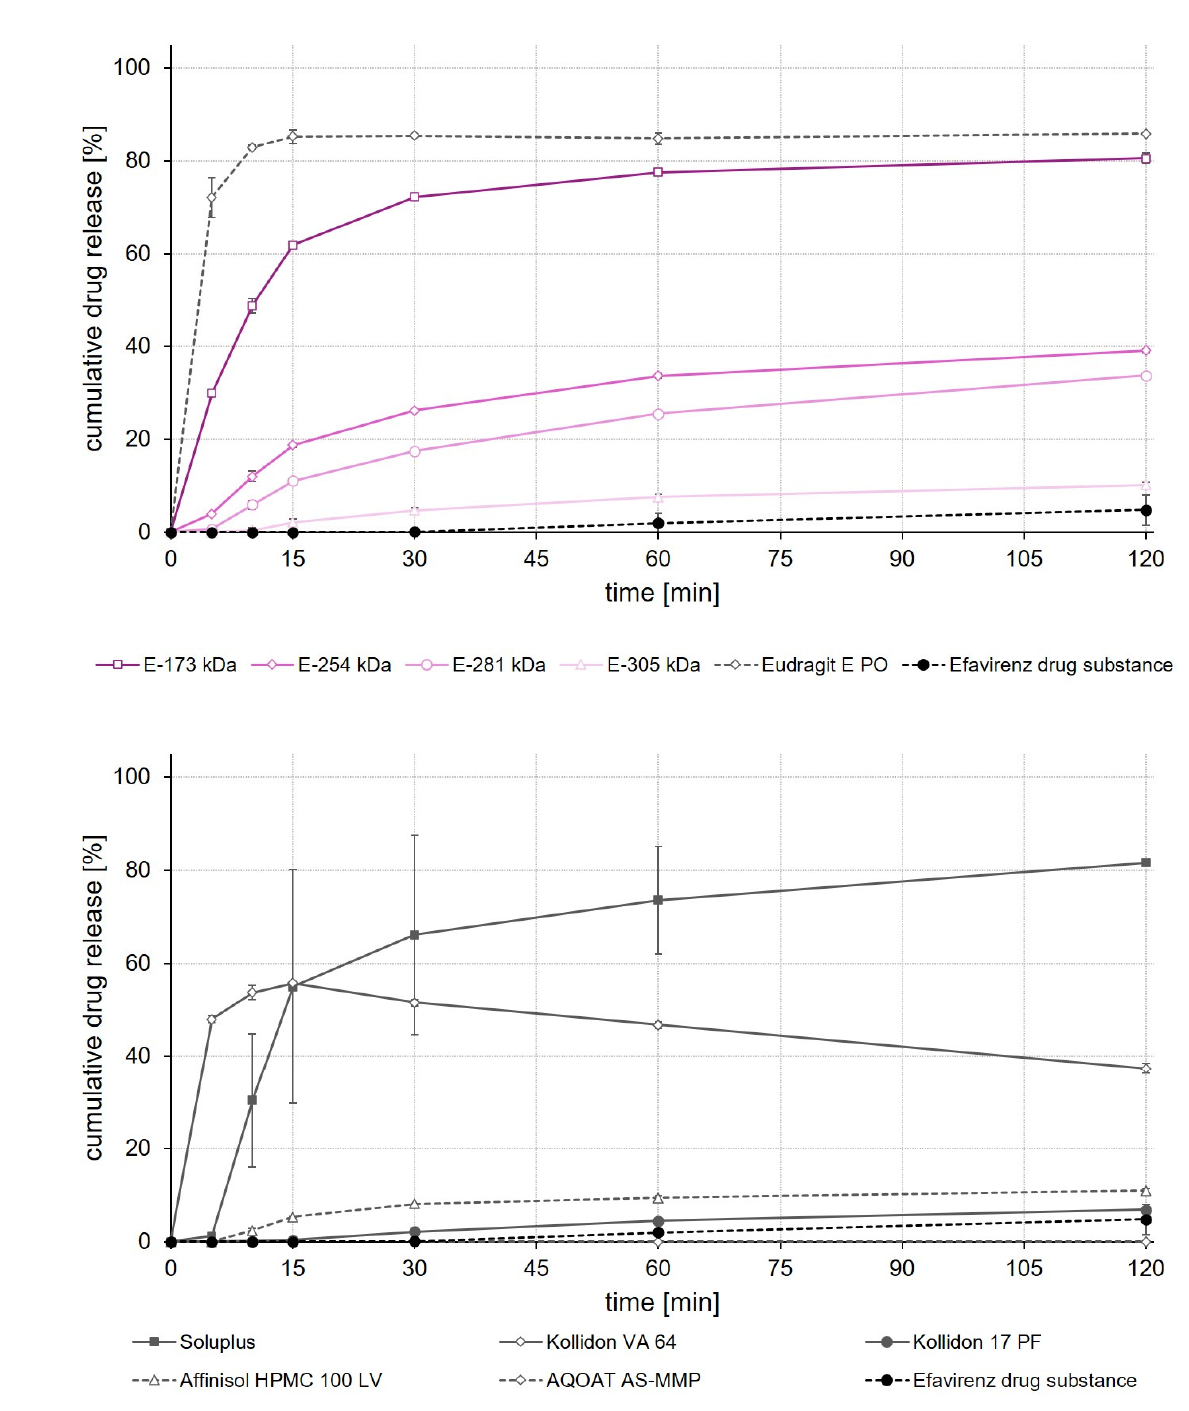
Figure 7. Dissolution profiles of efavirenz drug substance and efavirenz ASDs based on ModE and EPO ( a ), as well as efavirenz drug substance and efavirenz ASDs based on other marketed (co-)polymers ( b ) in 500 mL 0.1 M HCl in USP apparatus II. Each value designates the mean ± S.D. (n = 3).